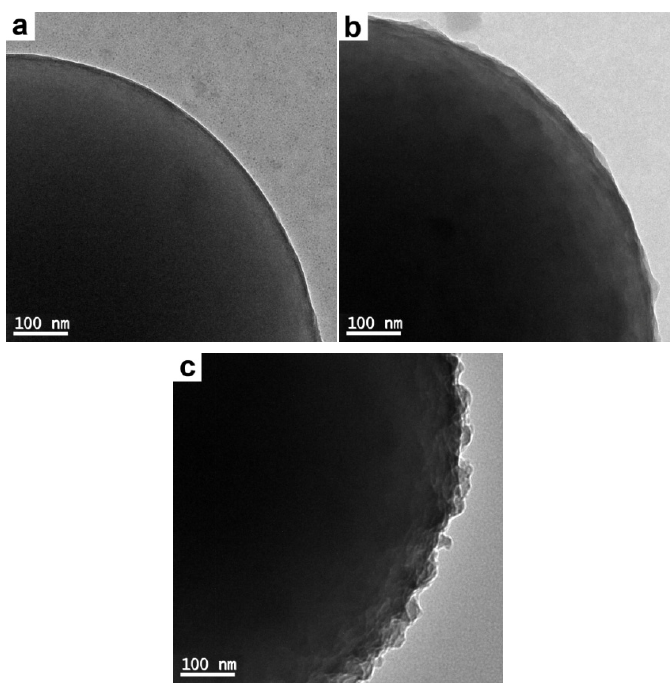
Figure 8. TEM images of the products prepared with varied PS amounts and a fixed amount of AT (0.2 g) at higher magnifications: ( a ) 0.2 g (run 5); ( b ) 0.1 g (run 6), and ( c ) 0.05 g (run 7). The overlayer thickness of the coated particles was measured to be ~ 7, ~ 17, and ~28 nm, respectively.